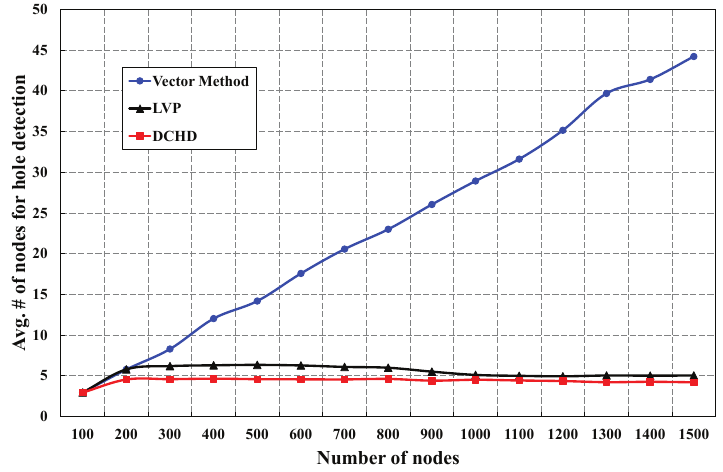
Figure 11. Comparison of DCHD in terms of the average number of nodes to detect a